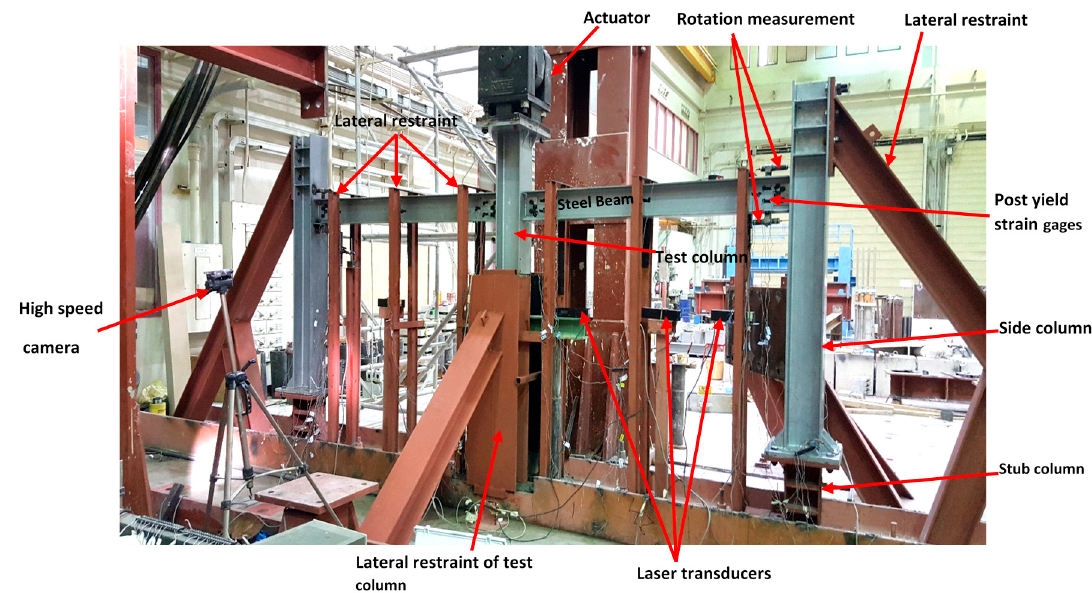
Figure 3. Instrumented specimen ready for testing [6].